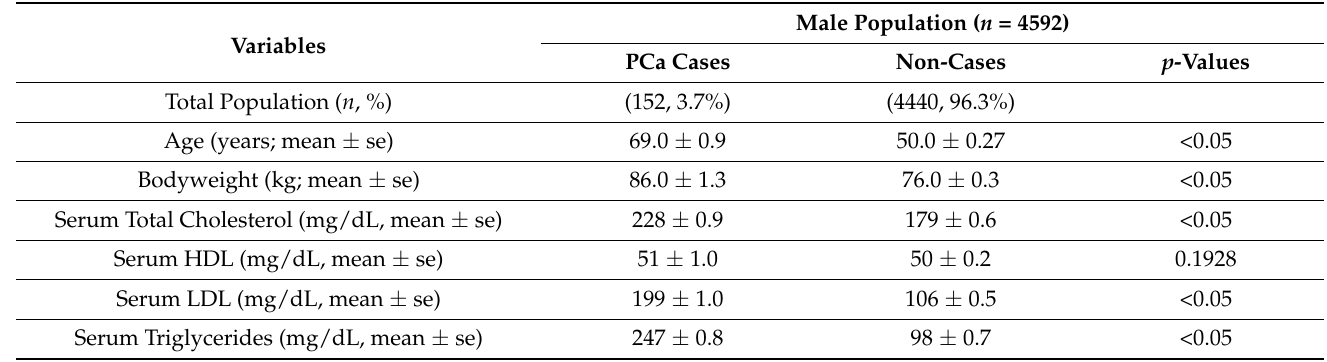
Table 4. Age, weight, and lipid profile levels (mg/dL) in the male population; NHANES 2005–2015.